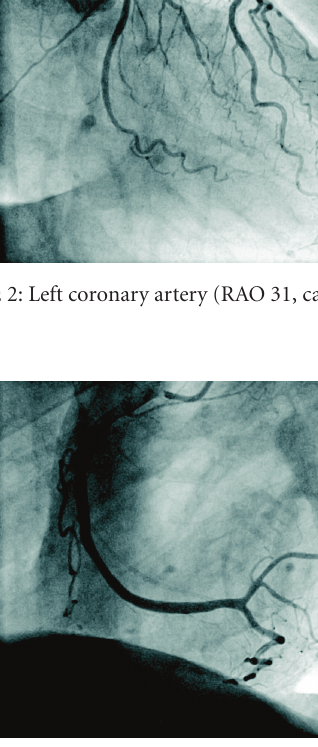
Figure 3: Right coronary artery (LAO 53, caudal 0,3).